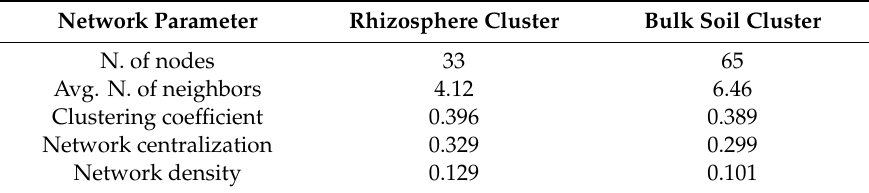
Table 3. Network parameters of the co-occurrence network shown in Figure. 3.